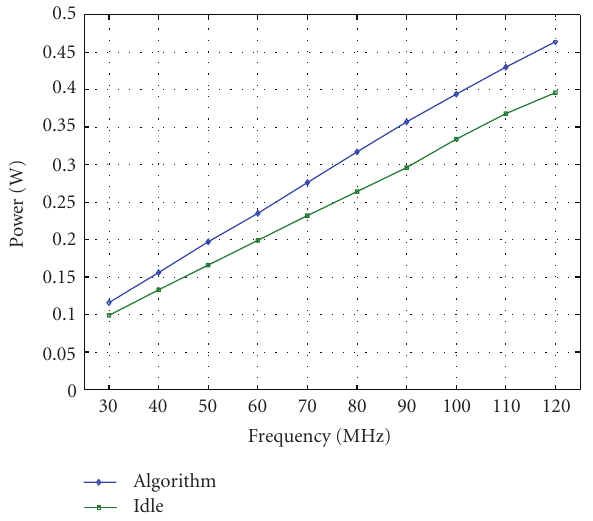
Figure 14: MicroBlaze power